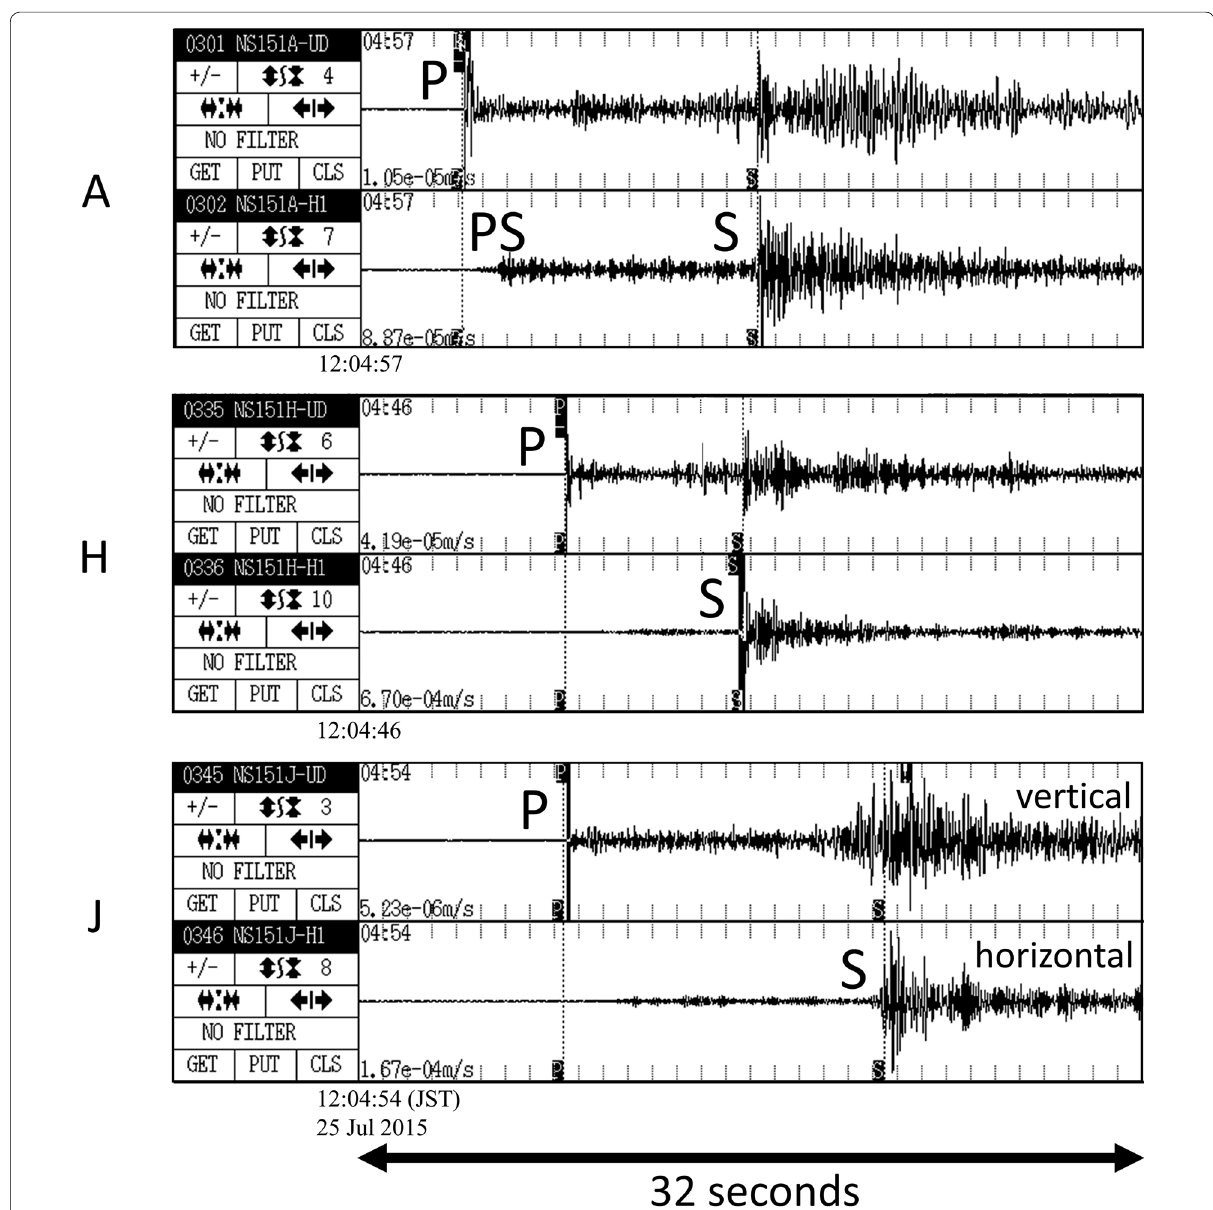
Fig. 2 Examples of seismograms observed by OBSs A, H, and